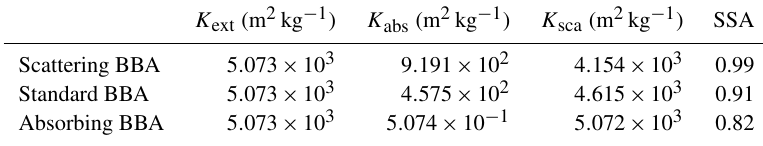
Table 2. Dry (relative humidity is 0%) optical properties at 550nm for the aged smoke biomass burning